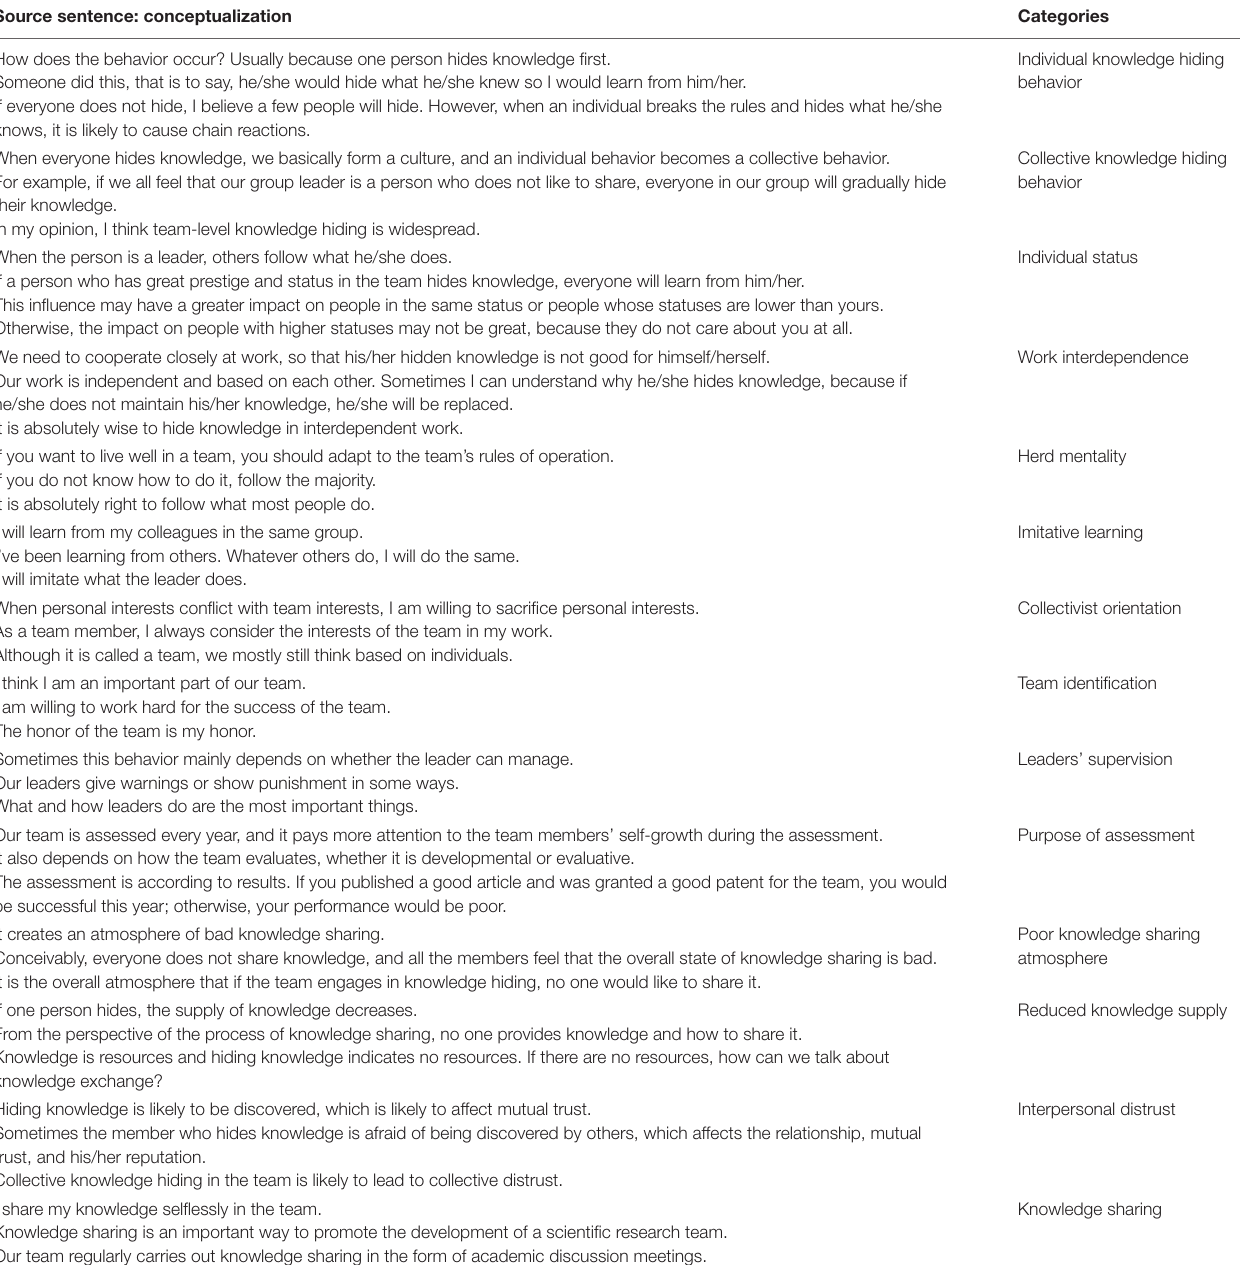
TABLE 2 | Results of